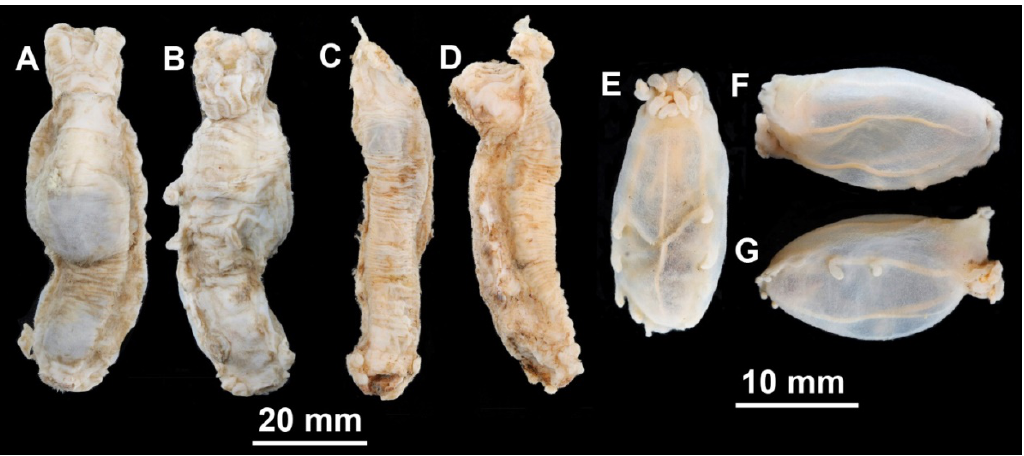
Figure 3. ( A , B ) Peniagone mus , IORAS ECH02148, dorsal and ventral view; ( C , D ) Peniagone saveljevae sp. nov., holotype, IORAS ECH02165, dorsal and lateral view; ( E – G ) Peniagone minuta sp. nov., paratype, IORAS ECH02170, ventral, dorsal and side view respectively. ( A – D ), scale 20 mm; ( E – G ) scale 10 mm.